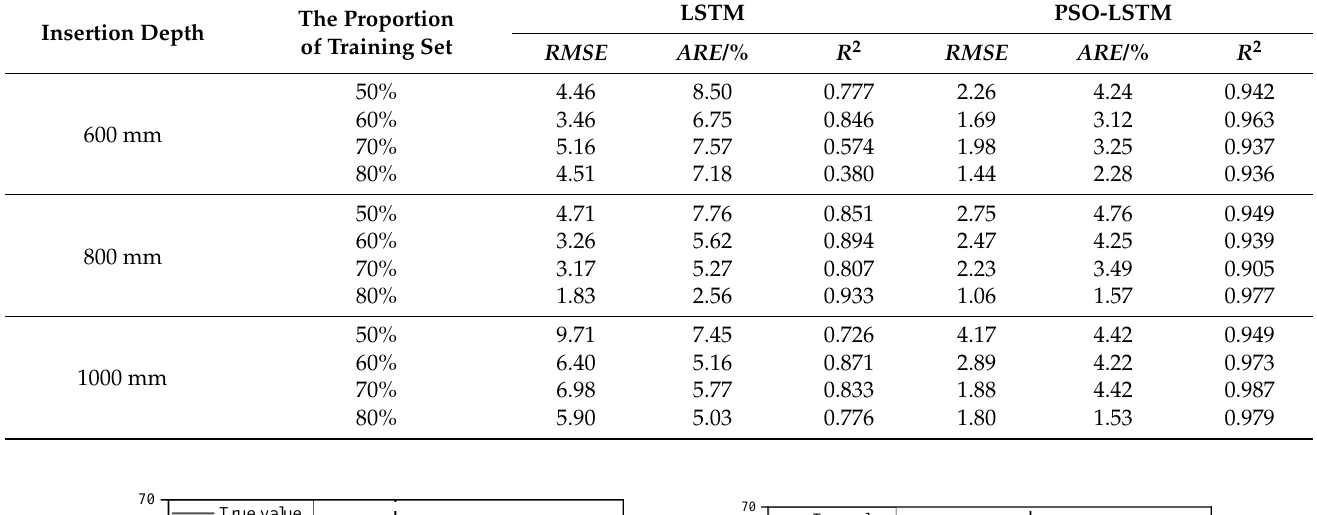
Table 6. LSTM and PSO-LSTM prediction performance of the gravel sample groups. The Proportion Insertion Depth of Training Set